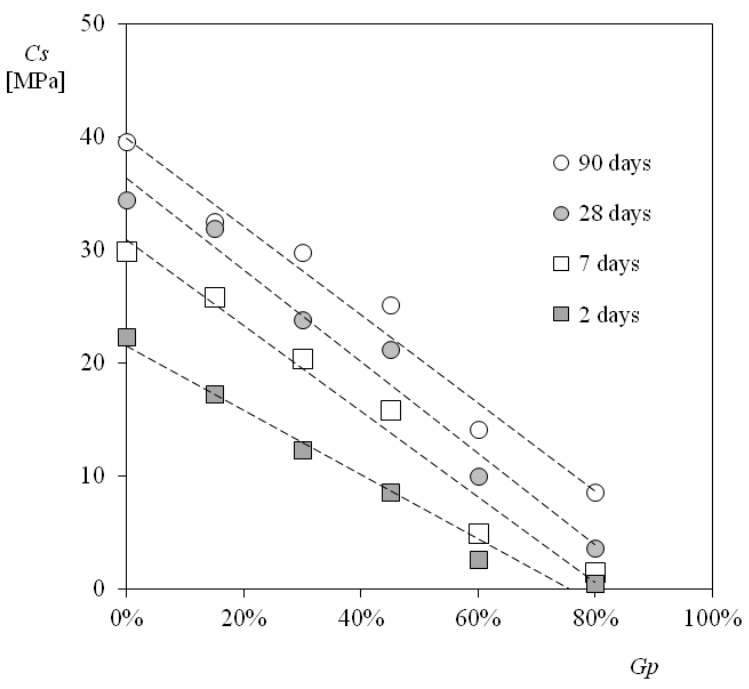
Figure 11. Variation of compression strengths, for test ages of 2, 7, 28 and 90 days, of concrete manufactured with different replacement percentages of cement by glass powder ( Gp ).